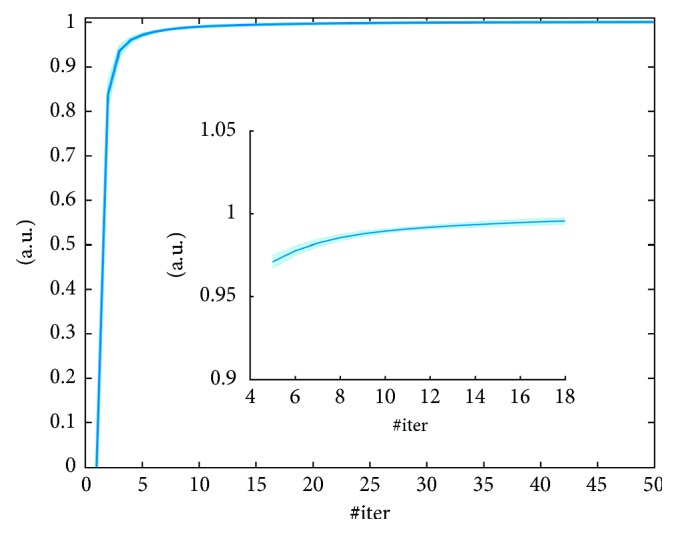
normL
n of the ICM-EM algorithm evaluated on clinical data. Inner box: zoomed version of the graph.